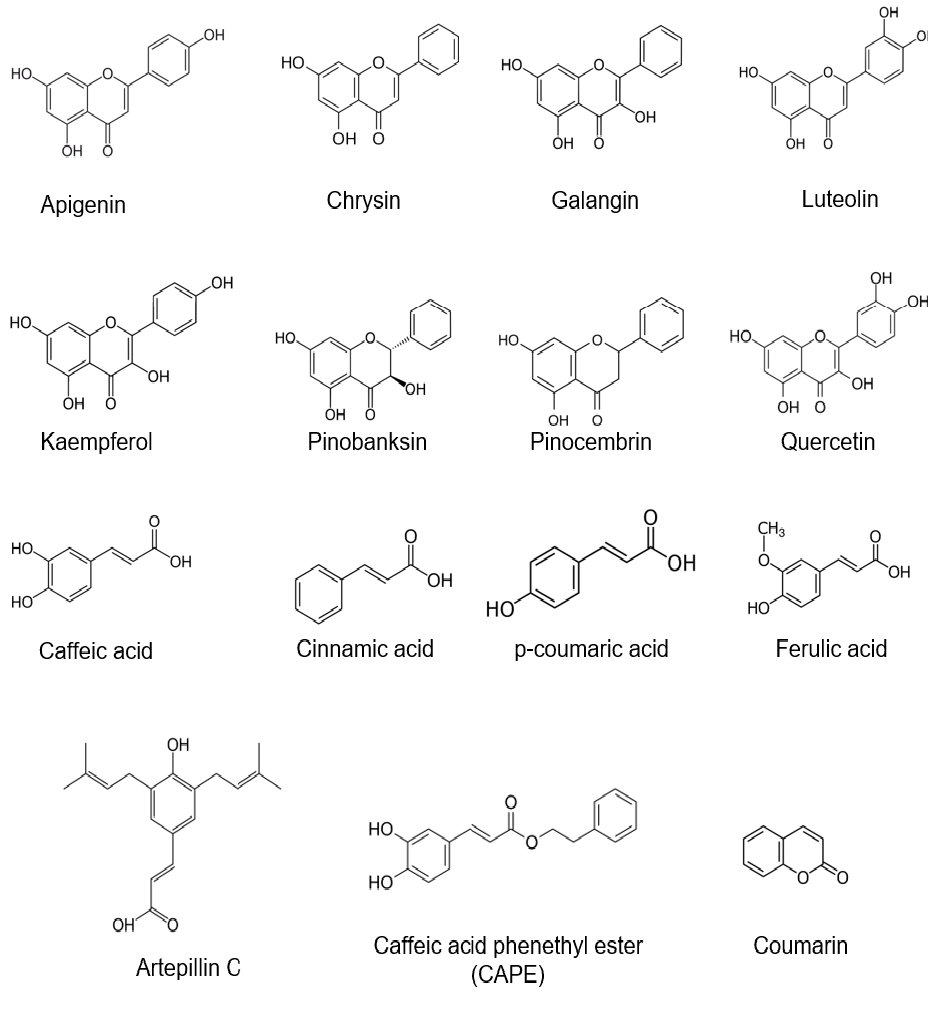
Figure 4. Common bioactive compounds in propolis.